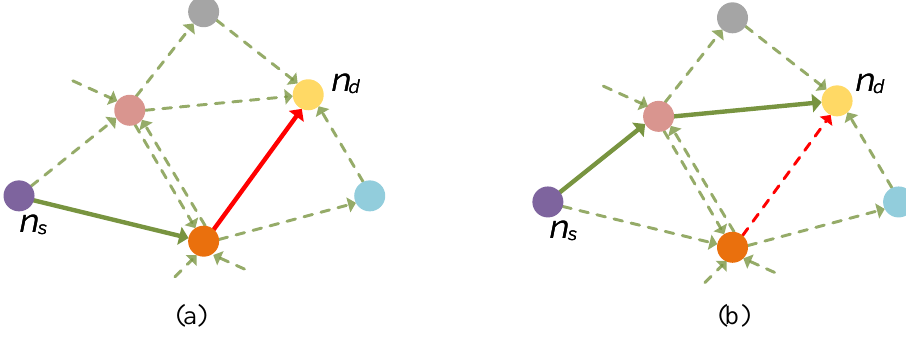
Figure 3. The visualization of our strategy. ( a ) Topology at time t ; ( b ) Topology at time t + 1. The red link represents the “to be congested” link, and the green represents the “no congestion” link. Our designed algorithm is expected to avoid selecting the “congestion link” to improve the next-coming